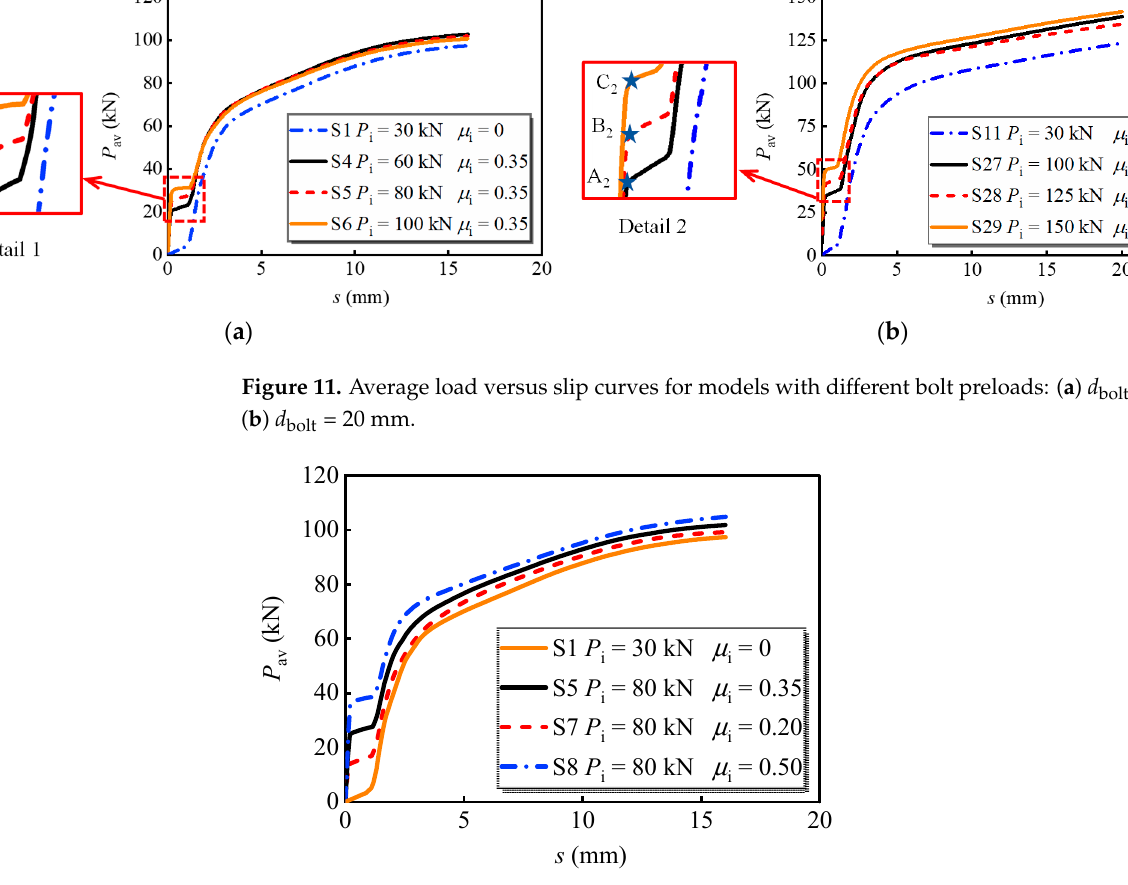
Figure 12. Average load versus slip curves for models with different friction coefficients.